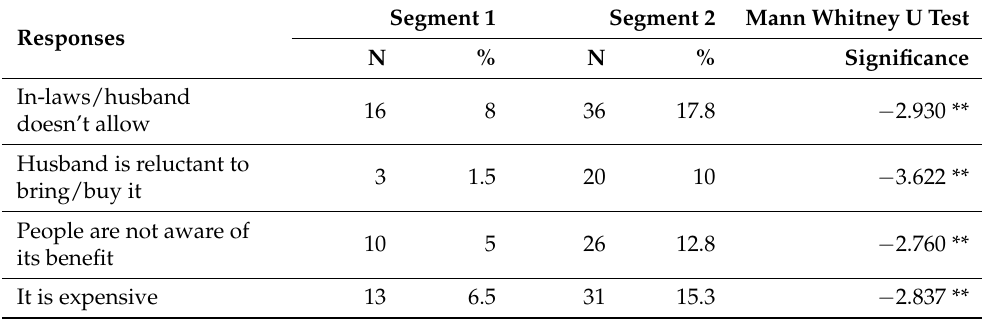
Table 4. Reported barriers to uptake of